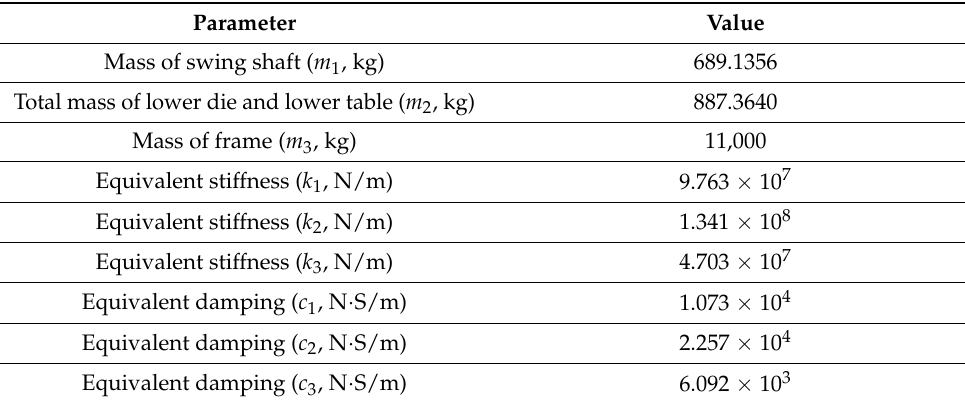
Table 1. The parameters of a T630 COF